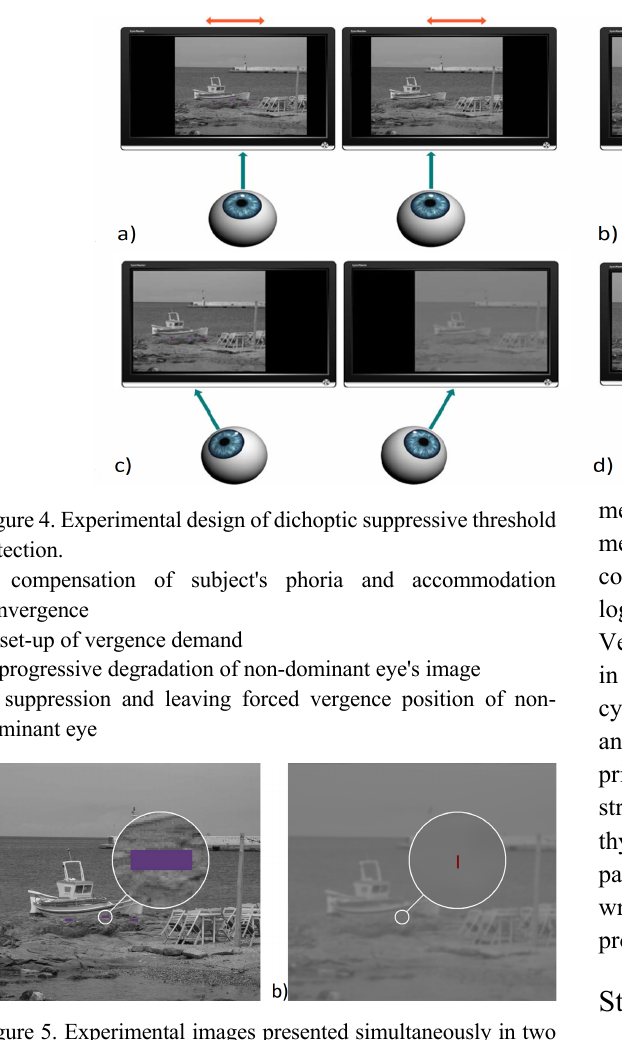
Figure 5. Experimental images presented simultaneously in two stimulation